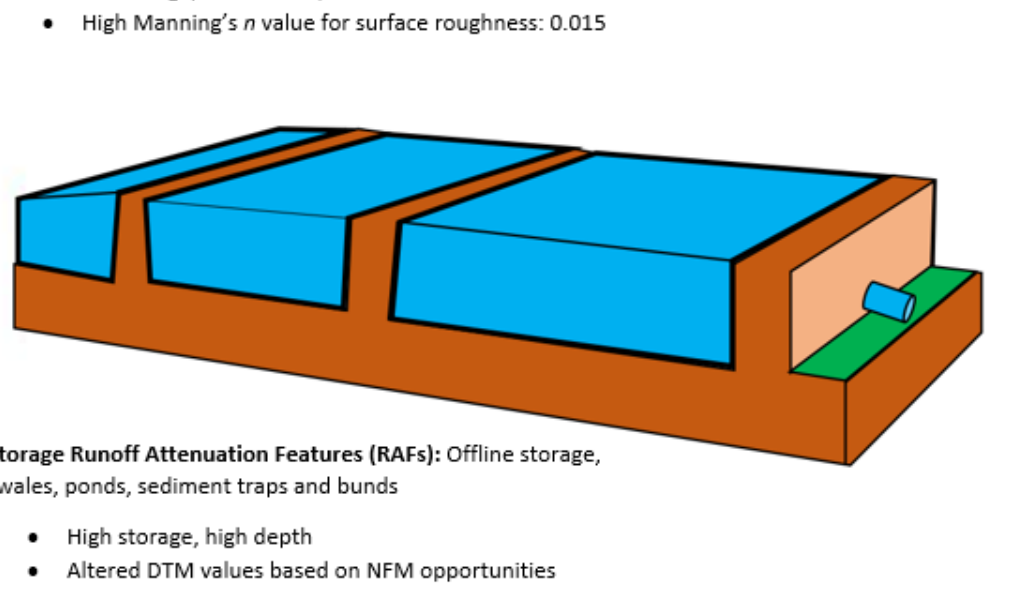
Figure 4. Schematic effects of NFM opportunities on flood flows in the model 2D domain. Figure 4 represents different NFM opportunities in the 2D active area of the model domain across the assortment of opportunities. This includes changing roughness values and altering the DTM to represent storage units within the floodplain. The model